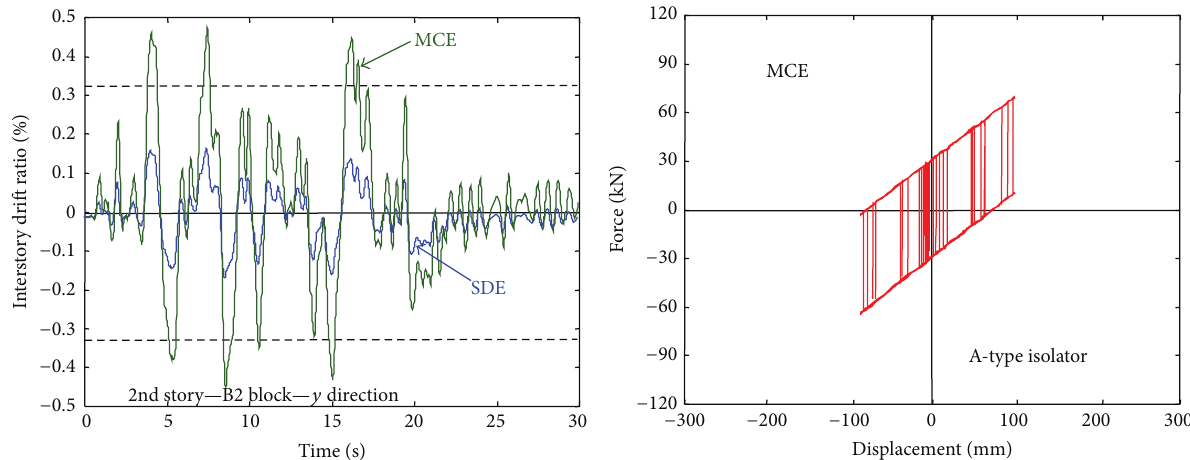
Figure 10: Second interstory drift ratio time-histories for B2 block and response cycles of most stressed DFP isolator obtained in 𝑦 direction from the most demanding MCE-scaled input accelerogram.